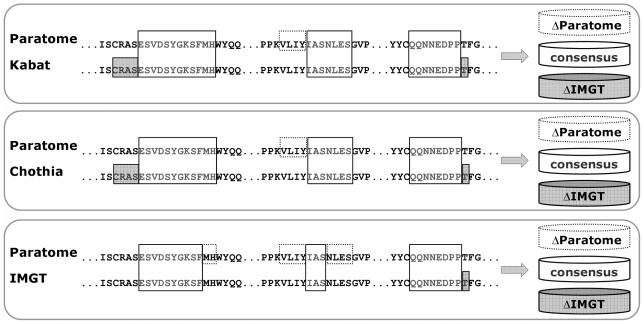
Comparison of consensus and method-specific residues.A light chain is analysed by all methods. In the top comparison, the residues identified by Paratome (grey, top line) are compared to those identified by Kabat (grey, second line). For L1, for example, both methods agree on the fragment ESVDSYGKSFMH, however, according to Kabat, CDR L1 includes also three amino acids N-terminal to this fragment (RAS, marked with a grey box) while according to Paratome these are not included in ABR L1. ABR L2, is identified by Paratome to be longer than the CDR L2 identified by Kabat by four residues (VLIY, marked with a dashed box).